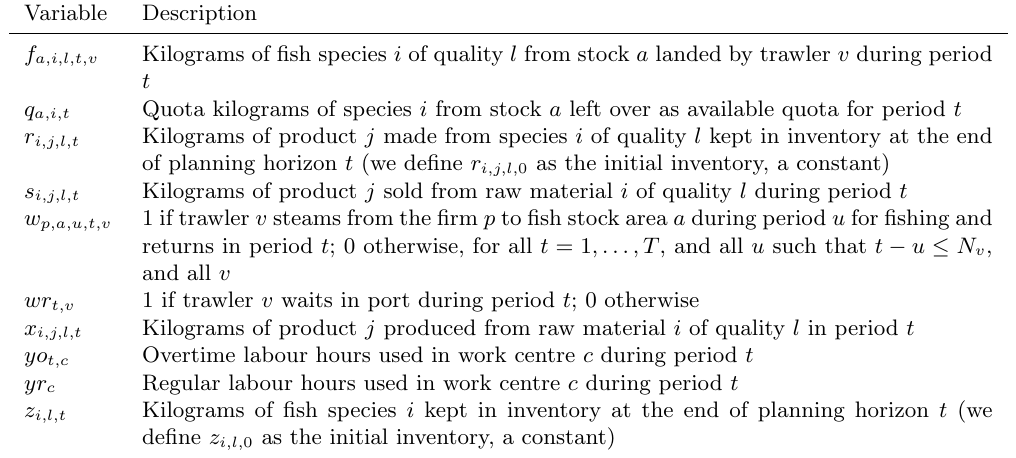
Table 4: Model decision